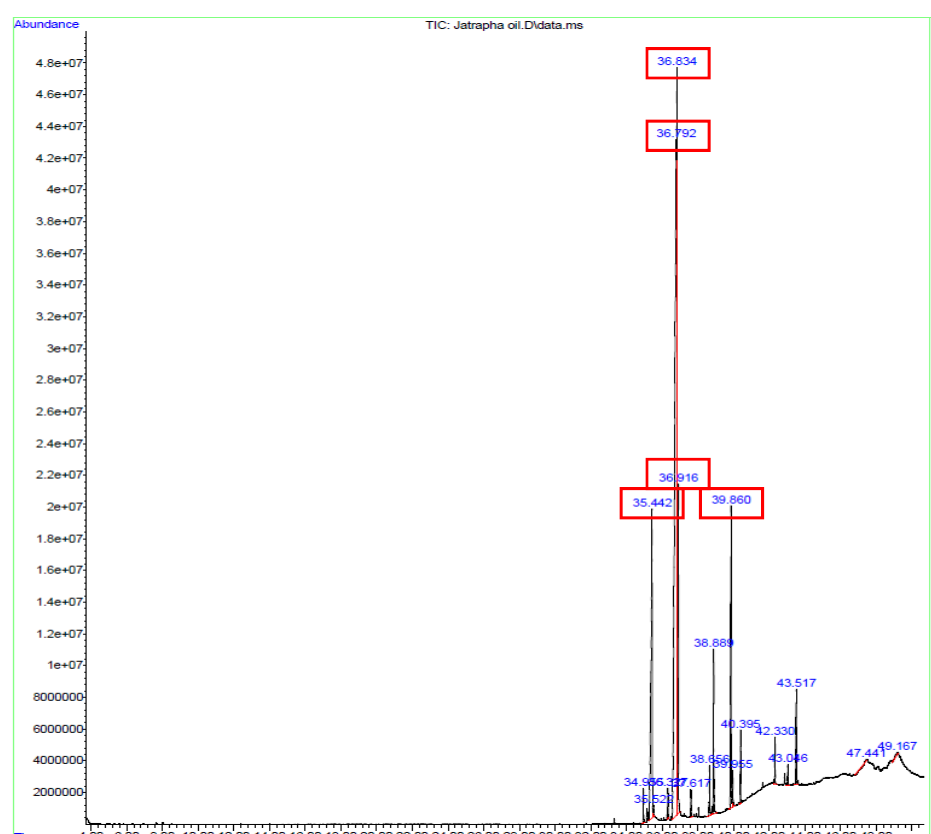
Figure 9. Fatty acid composition spectrum of Malaysian Jatropha seed oil from GC–MS.